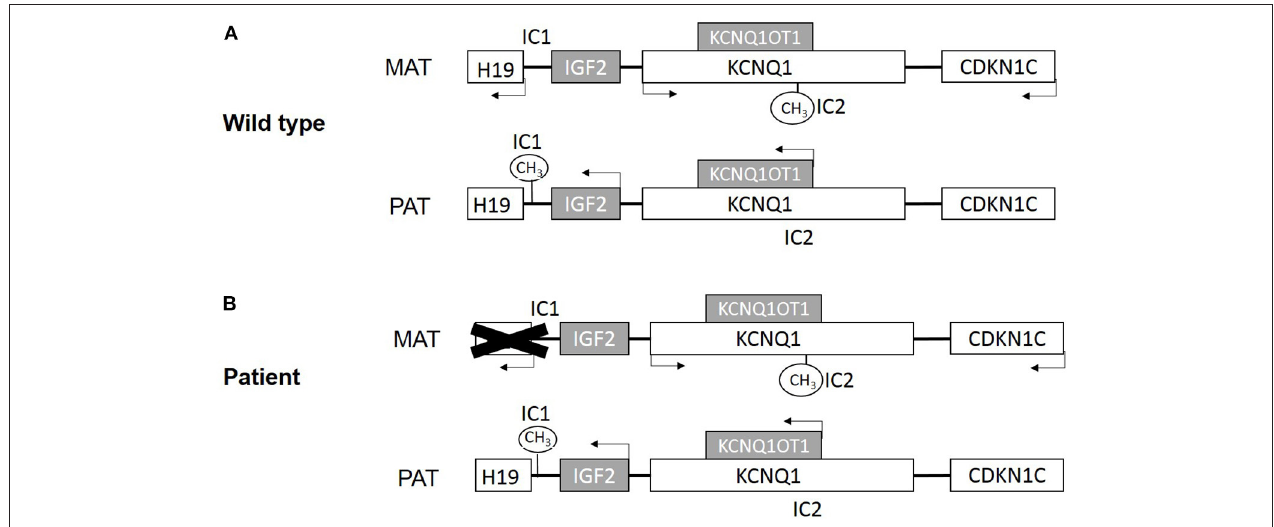
FIGURE 1 | (A) Scheme of imprinted gene cluster in wild type. (B) Scheme of imprinted gene cluster in patient. MAT, maternal derived; PAT, paternal derived. White boxes present maternal expression genes, and gray present paternal expression genes. IC1 is paternal methylation and IC2 is maternal methylation.